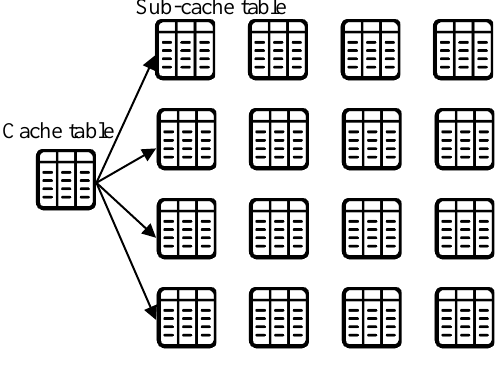
Figure 4. Schematic diagram of cache table split.